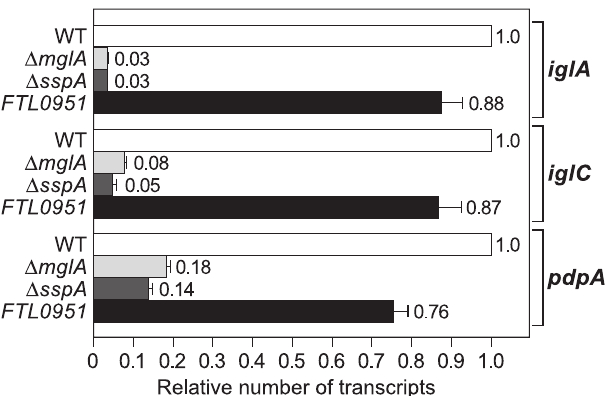
Figure 4. Both MglA and SspA Positively Control Virulence Gene Expression in F. tularensis Quantitative RT-PCR analysis of iglA, iglC, and pdpA transcript levels in wild-type (WT), D mglA, D sspA, and FTL0951 mutant backgrounds. Transcripts were normalized to tul4 whose expression is not influenced by MglA or SspA; compared to cells of the wild-type strain, cells of the D mglA mutant had 0.91 times (with an SE of 0.04) the number of tul4 transcripts, as determined by quantitative RT-PCR. Similarly, compared to cells of the wild-type strain, the D sspA, and FTL0951 mutants had 1.02 times (SE ¼ 0.12) and 1.47 times (SE ¼ 0.09) the number of tul4 transcripts, respectively.